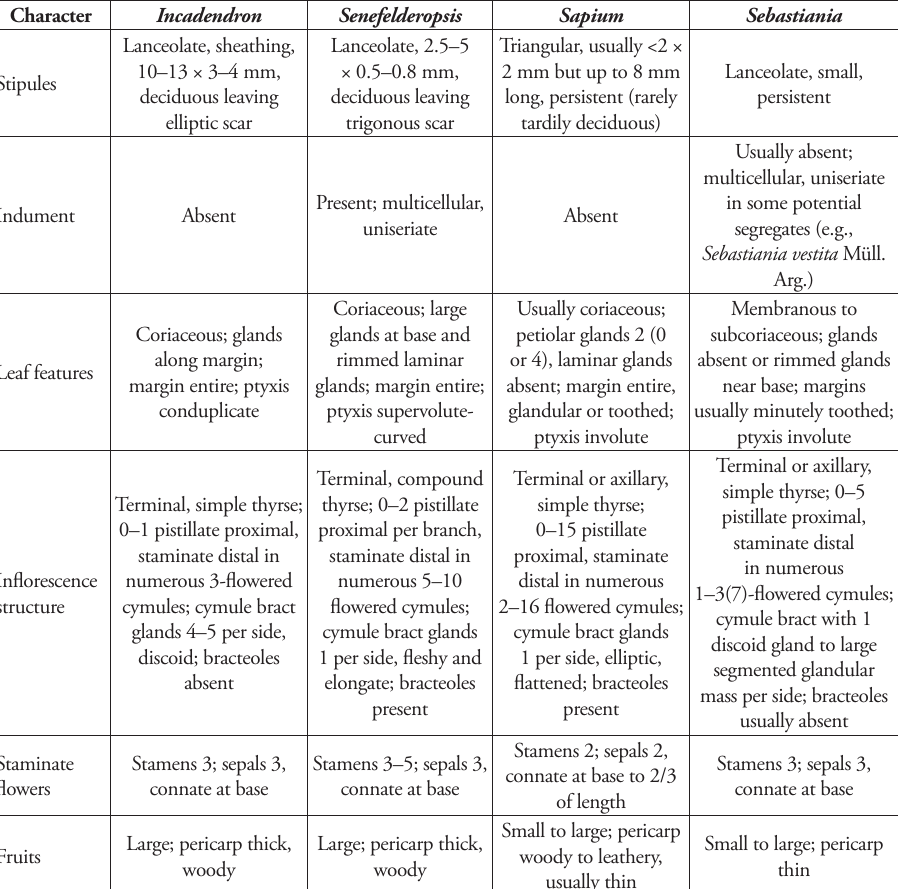
Table 1. Comparison of Incadendron with the morphologically most-similar neotropical genera. Based on primary observations with supplements from Kruijt (1996) and Esser (1995, 2001). The circumscription of Sebastiania is controversial leading to some uncertainty in the breadth of character